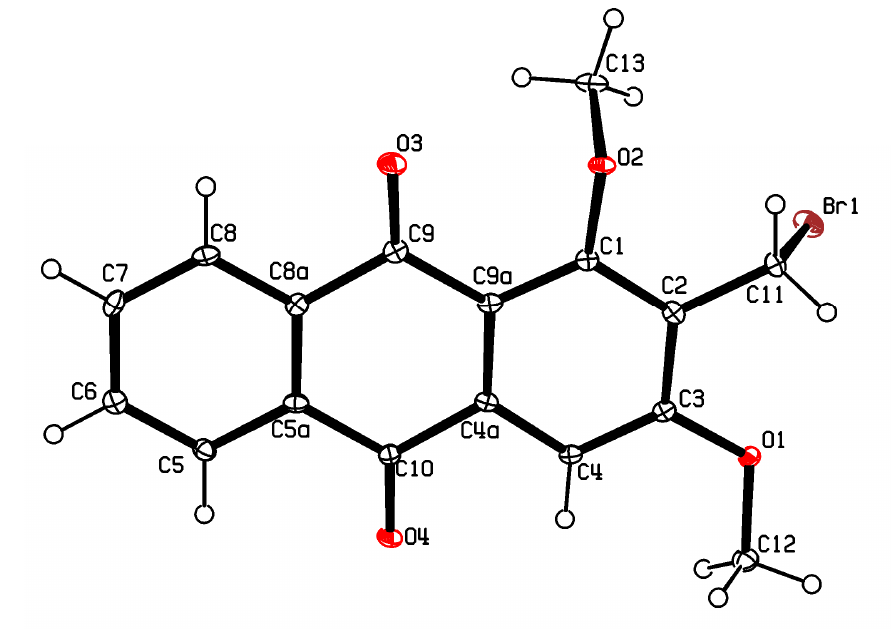
Figure 1. The ORTEP diagram of 2-bromomethyl-1,3-dimethoxy-9,10-athraquinone ( 5